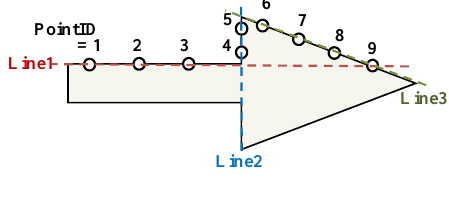
Figure 11. Illustration of line combining